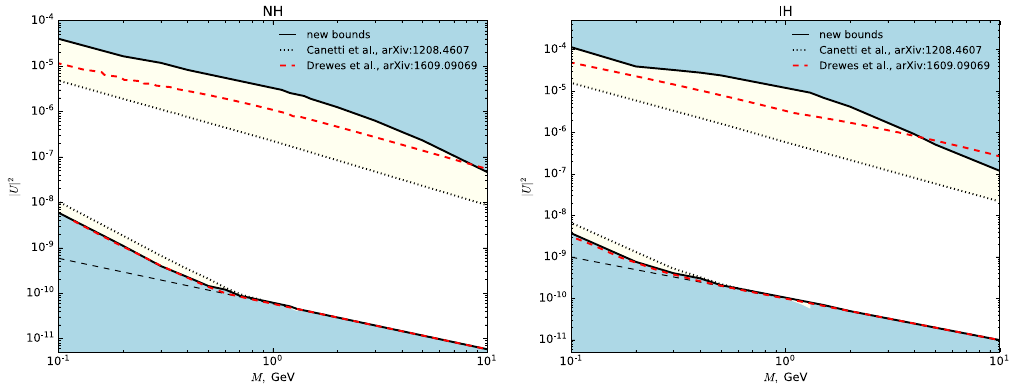
Figure 7 . Comparison of the bounds from three different works. Our lower bounds (black solid lines) are obtained from the parameter sampling, whereas upper bounds are obtained for fixed